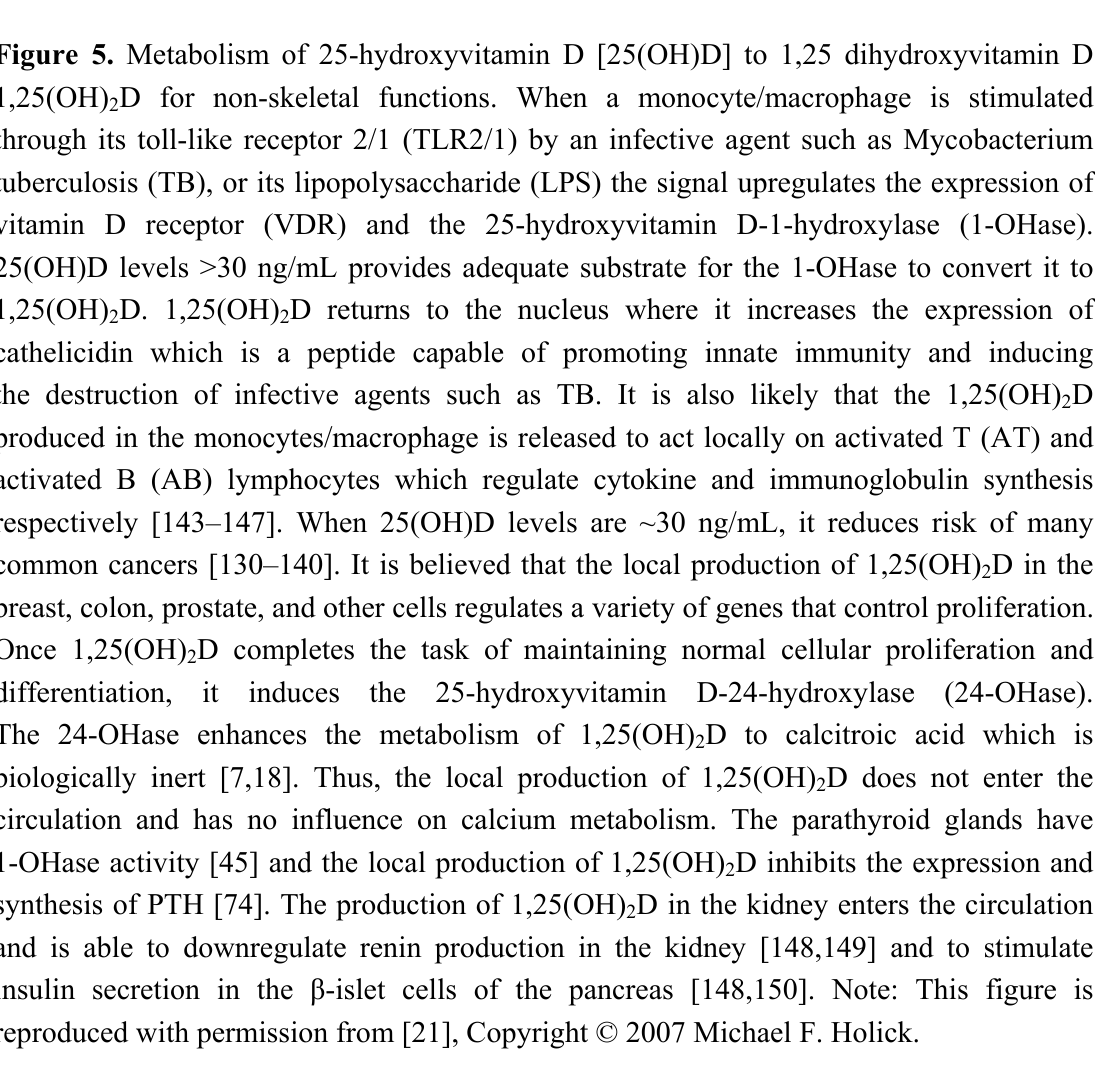
Figure 5. Metabolism of 25-hydroxyvitamin D [25(OH)D] to 1,25 dihydroxyvitamin D 1,25(OH) D for non-skeletal functions. When a monocyte/macrophage is stimulated 2 through its toll-like receptor 2/1 (TLR2/1) by an infective agent such as Mycobacterium tuberculosis (TB), or its lipopolysaccharide (LPS) the signal upregulates the expression